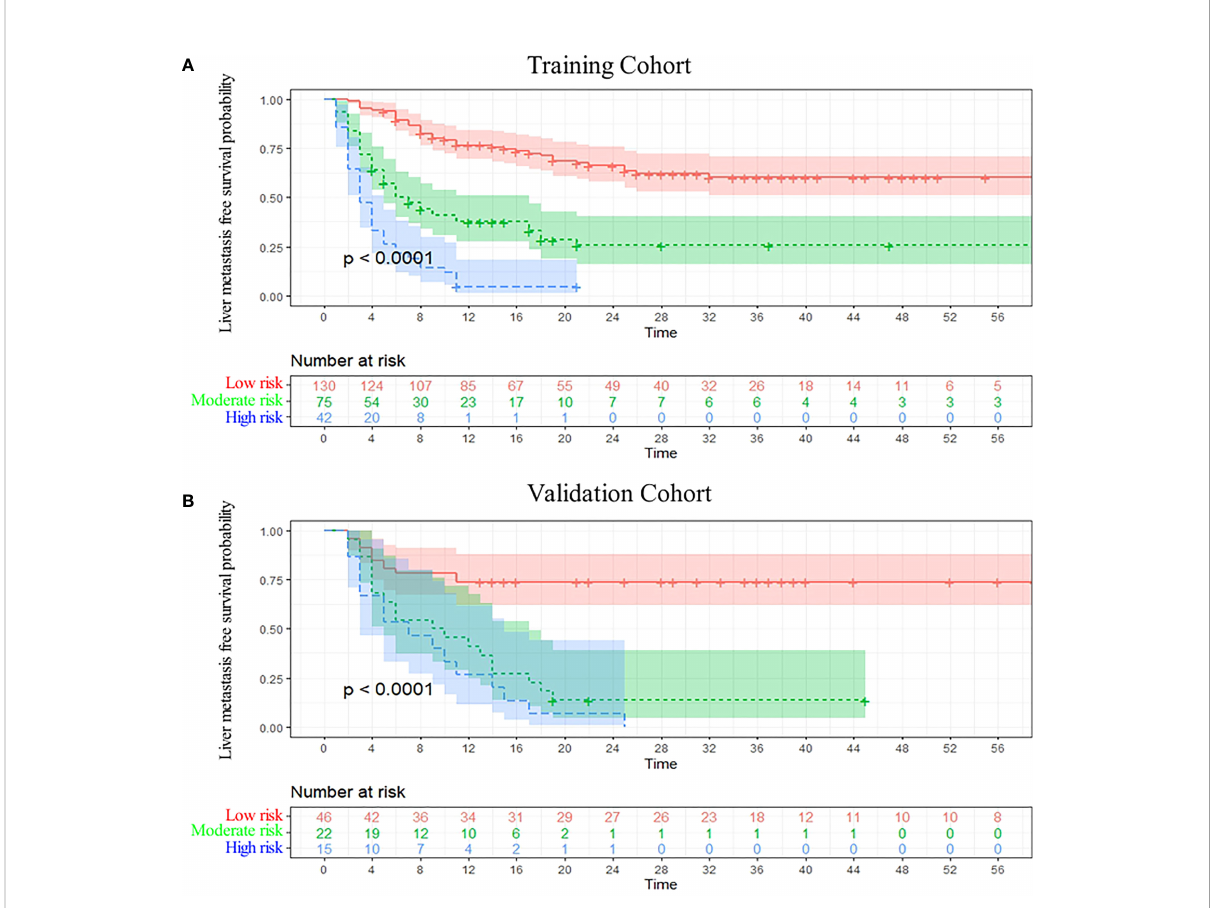
FIGURE 6 Kaplan-Meier curve analysis. Liver metastasis-free survival curves were strati fi ed by the model risk score in the training cohort (A) and the validation cohort (B)